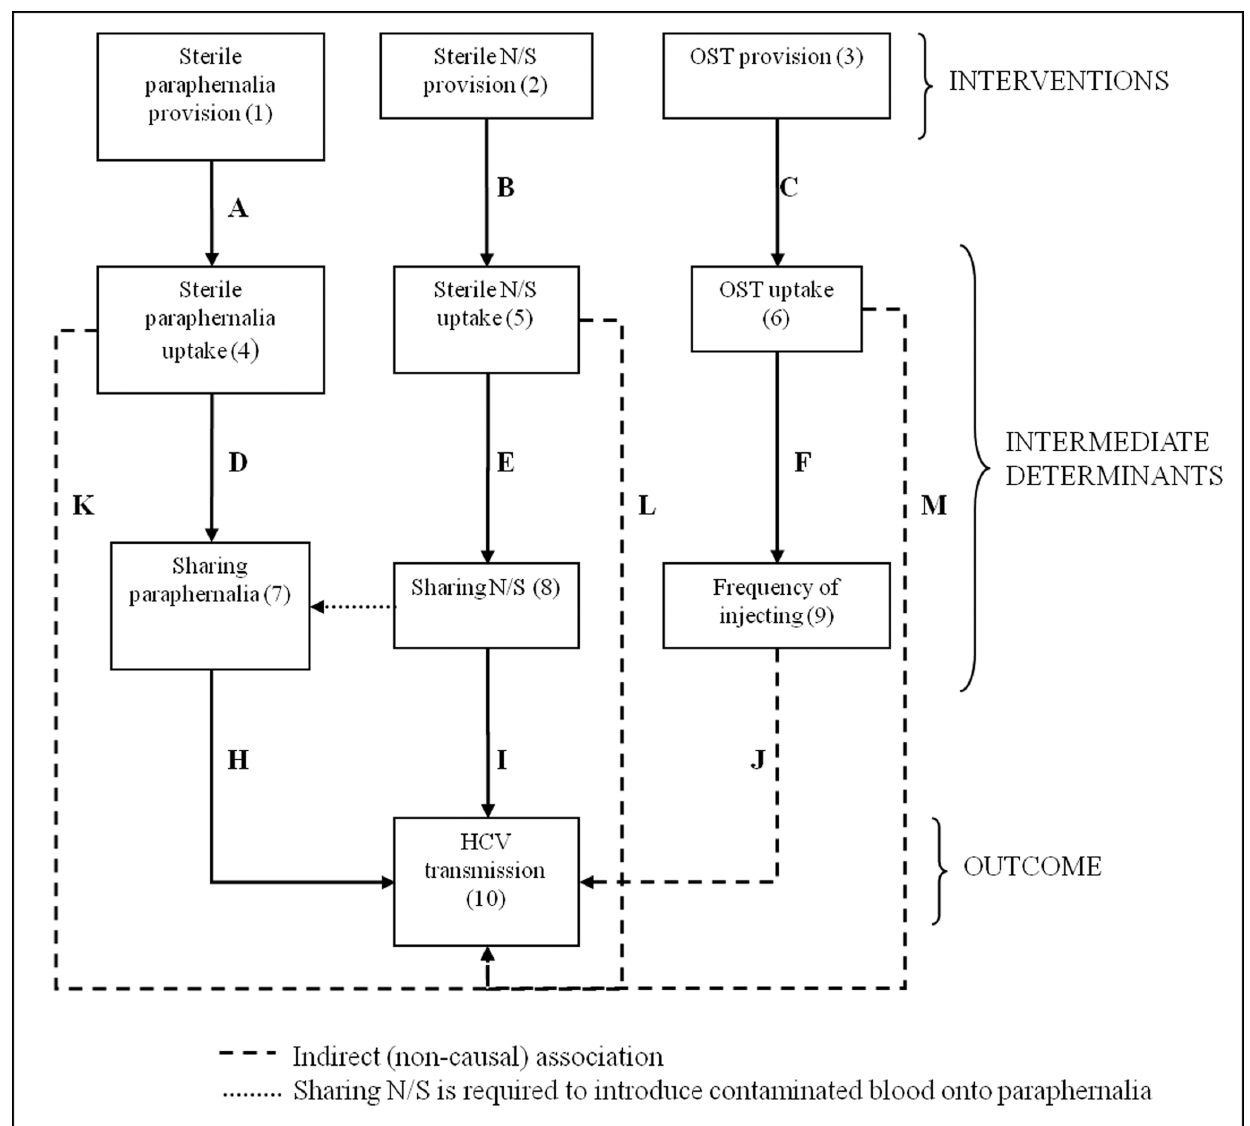
Figure 1. Analytical framework of potential associations between harm reduction interventions and HCV transmission. The arrows represent investigated associations: relationships A through C are group-level and relationships D through M are individual-level.